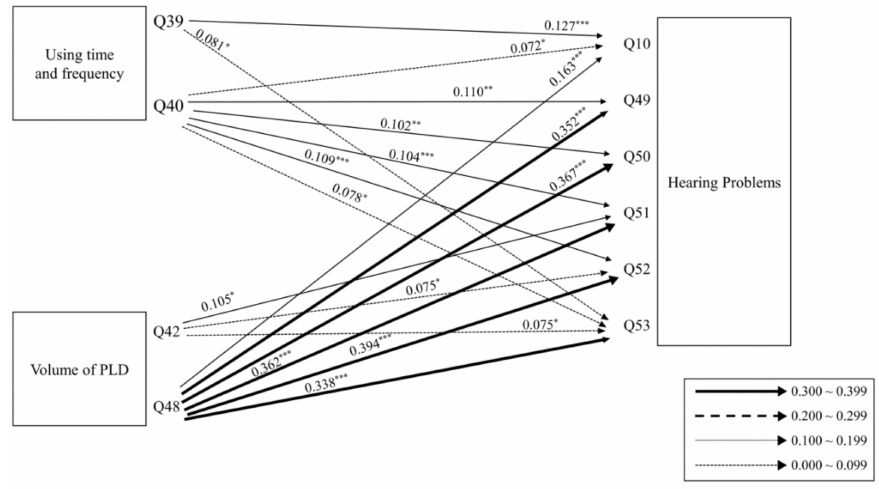
Figure 2. Path result for the first hypothesis based on a multiple regression model. * p < 0.05, ** p < 0.01, *** p <